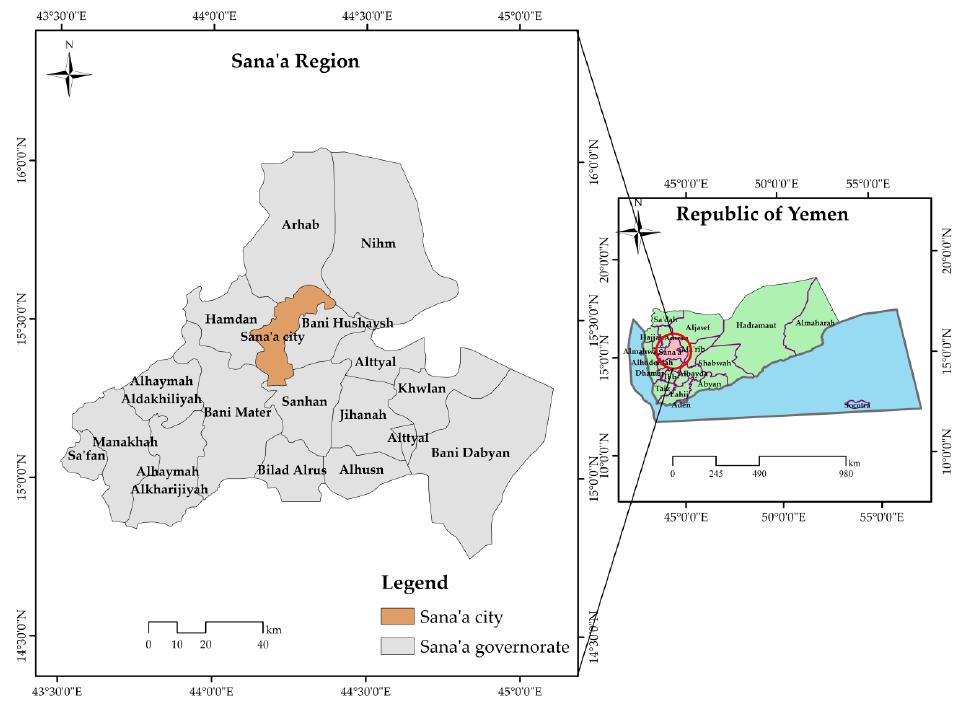
Figure 1. Sana’a region location